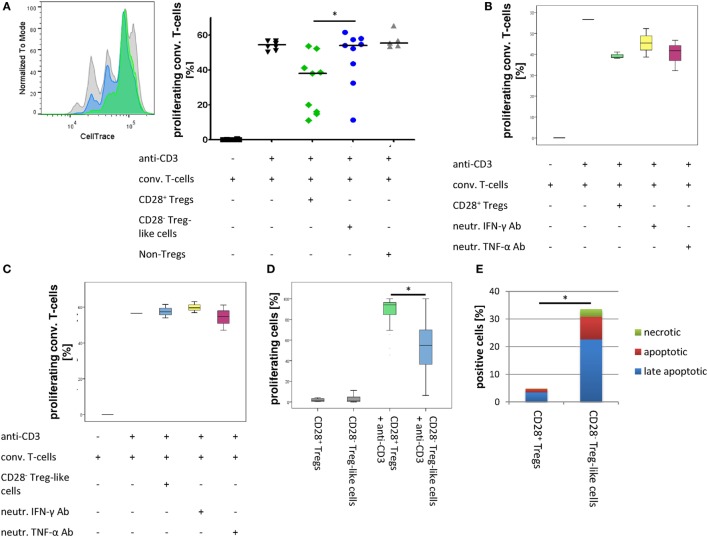
CD28− regulatory T-cells (Tregs)-like cells show reduced suppressive capacity. Graphs show (A) representative histograms and box plots of in vitro suppression assays with CD28+ Tregs (green), CD28− Treg-like cells (blue), as well as conventional T-cells (gray) of nine rheumatoid arthritis patients, (B) box plots of in vitro suppression assays with CD28+ Tregs (green) as well as (C) CD28− Treg-like cells (blue) in the presence of neutralizing ab to IFN-γ (yellow) or TNF-α (pink); (D) proliferative potential of CD28+ Tregs (green) and CD28− Treg-like cells (blue) following stimulation with anti-CD3; and (E) apoptotic (green), late apoptotic (blue), as well as necrotic (red) cells. Mann–Whitney U test was used to assess differences between groups. *p < 0.05.